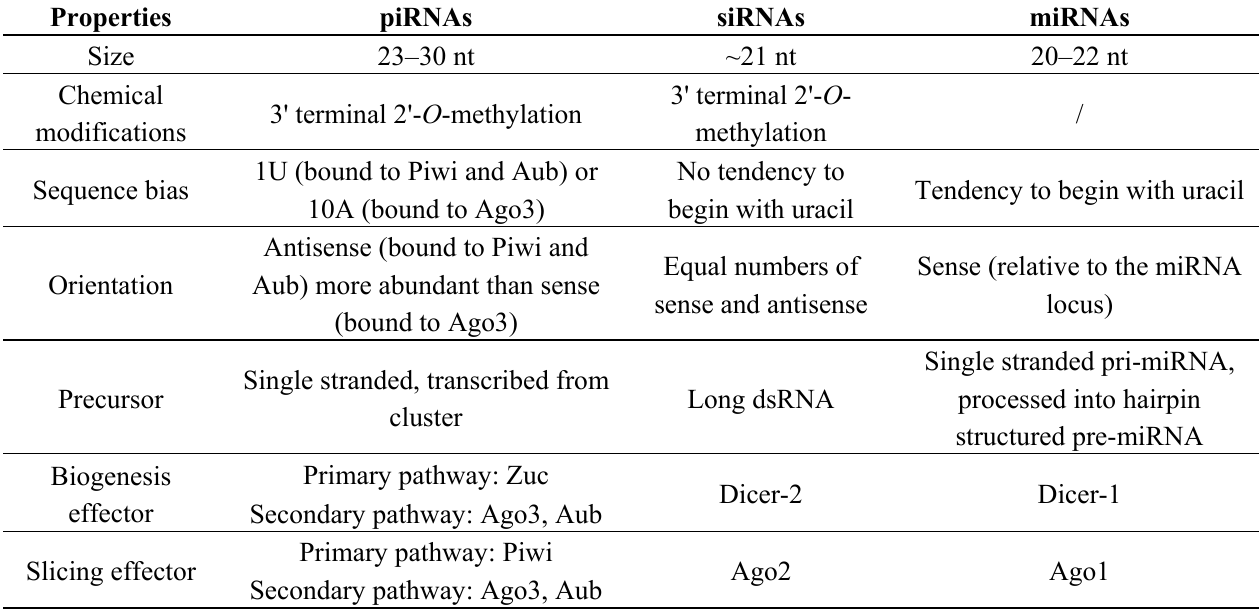
Table 1. Small RNA Properties. Data in this table come from D. melanogaster studies. However, these properties were found to be largely conserved in